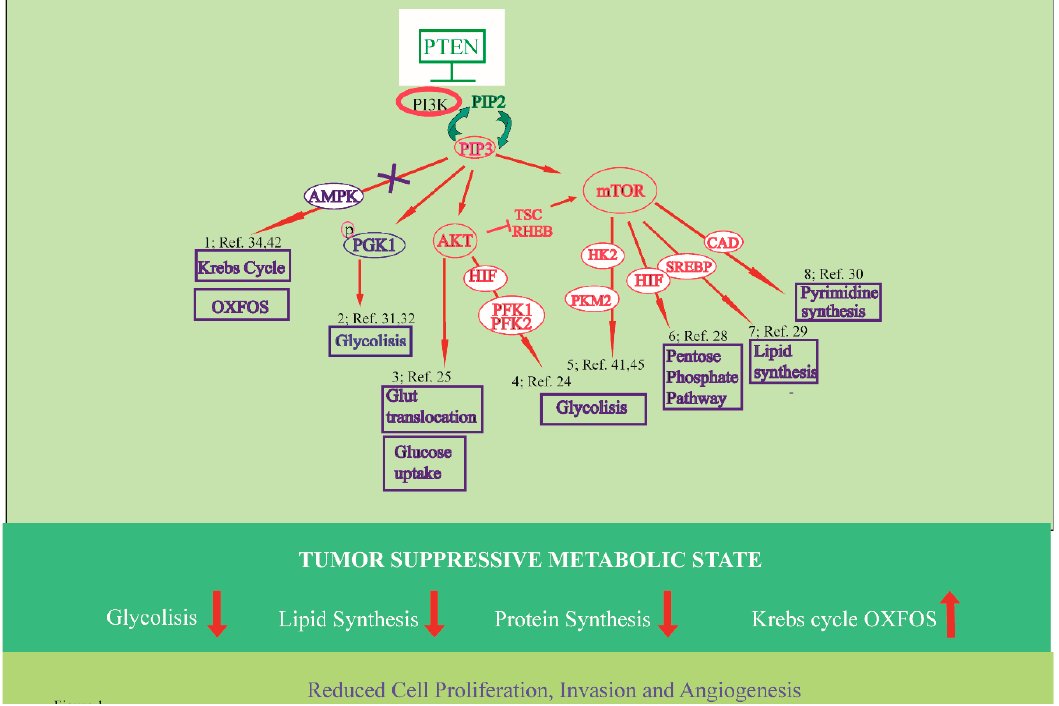
Figure 1. A schematic summary of metabolic pathways (upper panel) determining the tumor suppressive activities (lower panel) for PTEN . See the text for details. (1) PTEN through AMPK induces Krebs cycle and OXFOS. (2) PTEN suppresses glycolysis through PGK1 inhibition. (3) PTEN blocks AKT induced Glut1 translocation and glucose uptake. (4) PTEN blocks mTOR-induced HIF1, PFK1, and glycolysis. (5) PTEN blocks mTOR-induced PKM2 transcription. (6) PTEN decreases PPP flux. (7) PTEN blocks mTOR-induced SREBP transcription factor and lipid synthesis. (8) PTEN reduces pyrimidine synthesis.